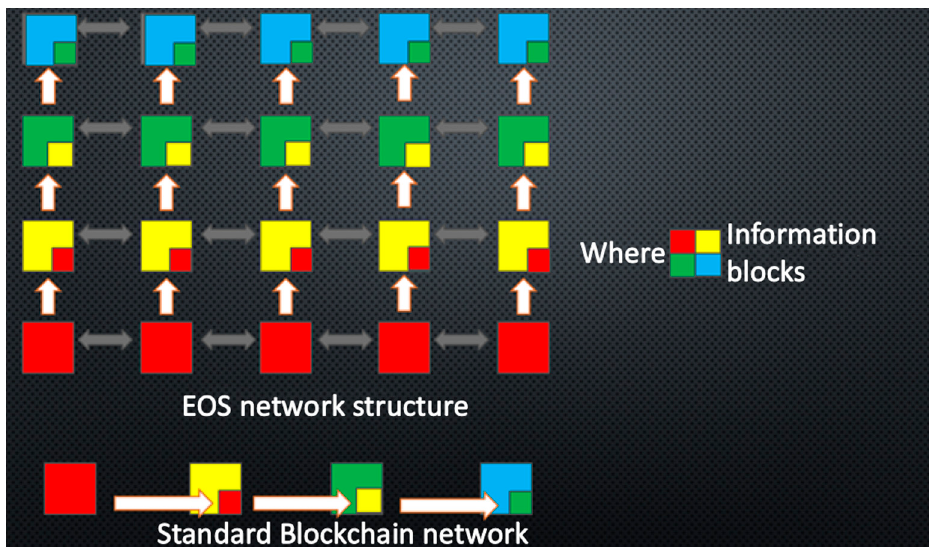
Figure 7. Schematic representation of the system building chains in cryptocurrencies. Source: https://ru.tradingview.com.